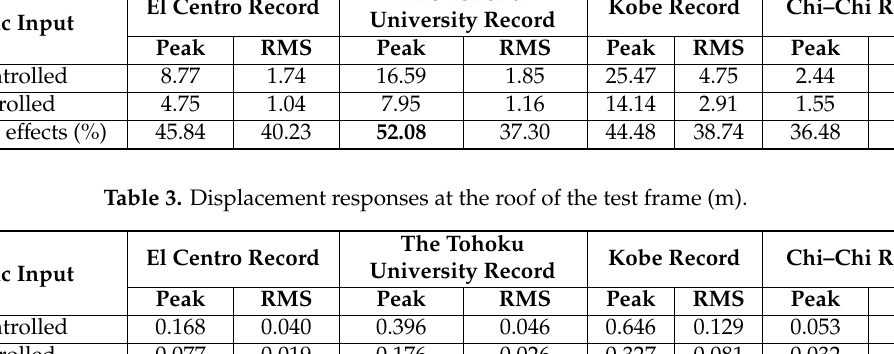
Table 2. Acceleration responses at the roof of the test frame (m / s 2 ).